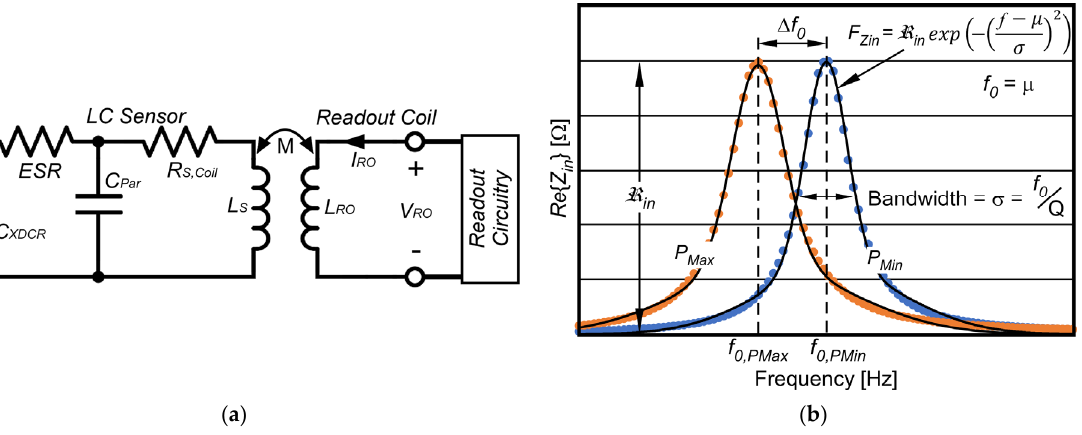
Figure 2. ( a ) Wireless inductive Pressure Gradient Measurement (PGM) System circuit model illustrating the LC sensor and readout coil and circuitry. ( b ) Two Re { Z in } datasets illustrating relevant parameters.